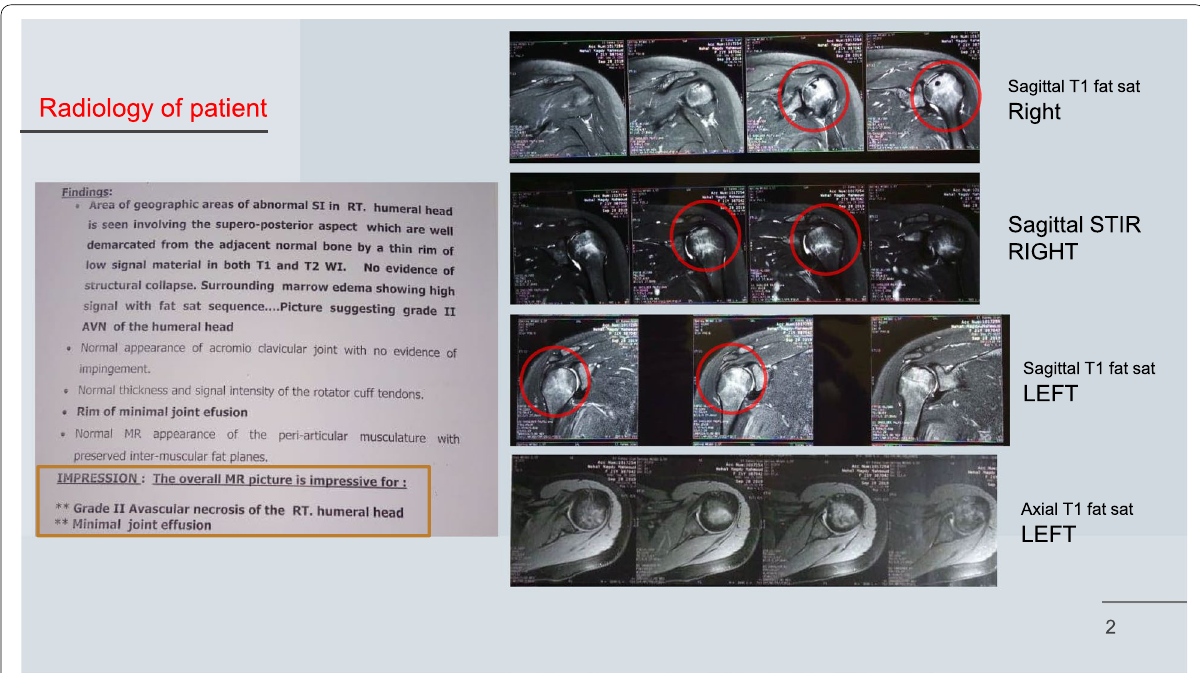
Fig. 2 MRI of both shoulders revealed abnormal signals in the right humeral head involving the superior-posterior aspect which are well demarcated from the adjacent normal bony by a thin rim of low signal material in both T1 and T2 WI. No evidence of structural collapse with marrow edema showing high signal with fat sat sequence. Conclusion: grade II AVN of the right humeral head and grade I AVN of the left humeral head with minimal joint